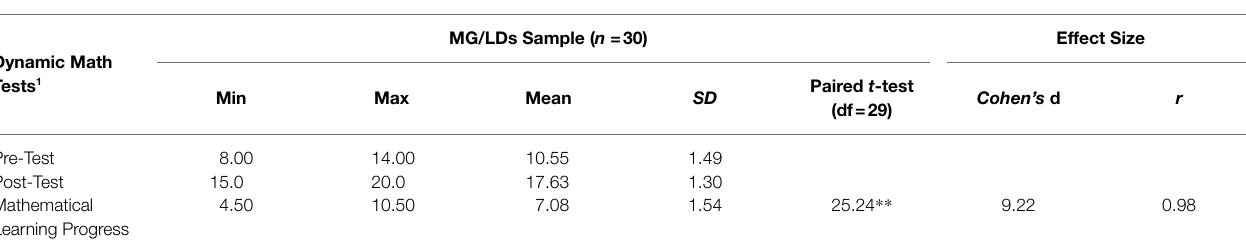
TABLE 2 | Mathematical learning progress for the MGLDs/2E